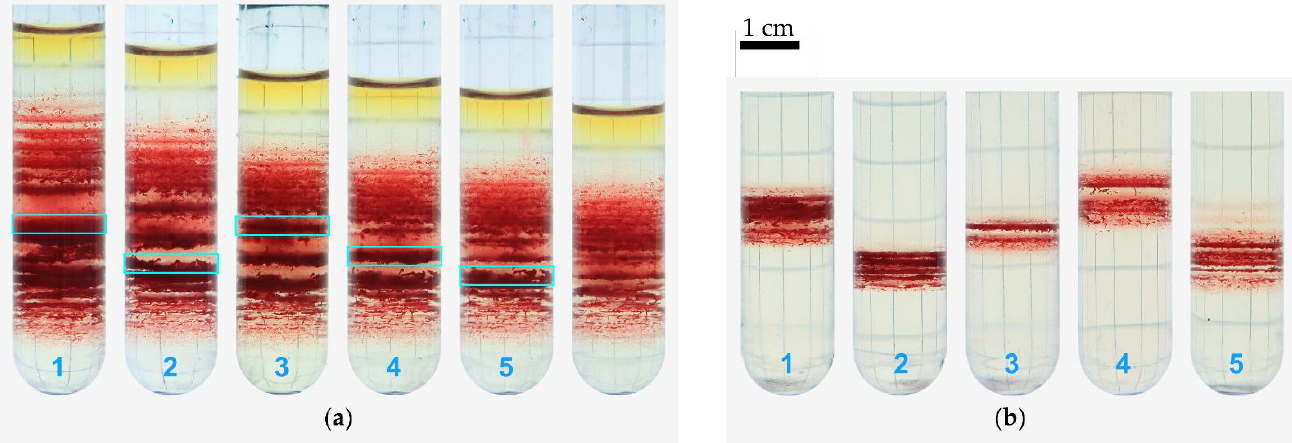
Figure 3. Bands were subsequently extracted from the distribution of a full blood sample ( a ), using a syringe pump, compare to Figure 1b. Each succeeding image in ( a ) shows the tube after extraction of the labeled layer. In a second step, the collected cells were layered on top of another Percoll suspension of identical composition as in the first centrifugation and centrifuged under equivalent conditions ( b ). Band 3 appears lower due to a thinning caused by a larger buffer volume. The scale bar is valid for both panels.